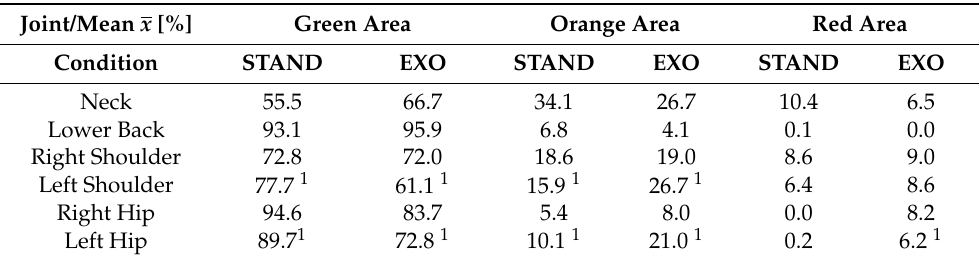
Table 4. Verification of measured motion data file normality is performed using the Shapiro-Wilk normality test. For each file we tested the null hypothesis: “The sample distribution is normal.” If the p -value was less than the significance level α , then the null hypothesis was rejected and the distribution was